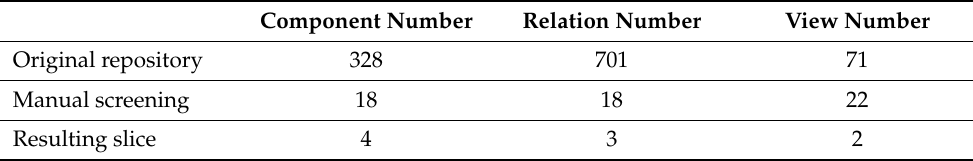
Table 2. The number of components, relations, and views before and after slicing. Component Number Original repository Manual screening Resulting